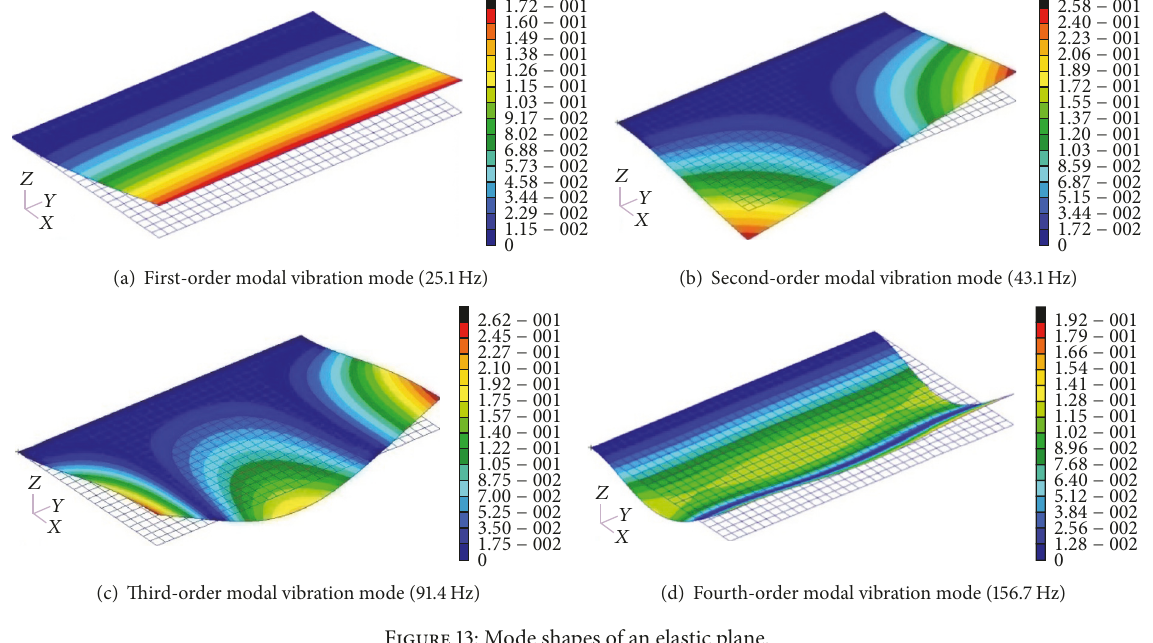
Figure 13: Mode shapes of an elastic plane.